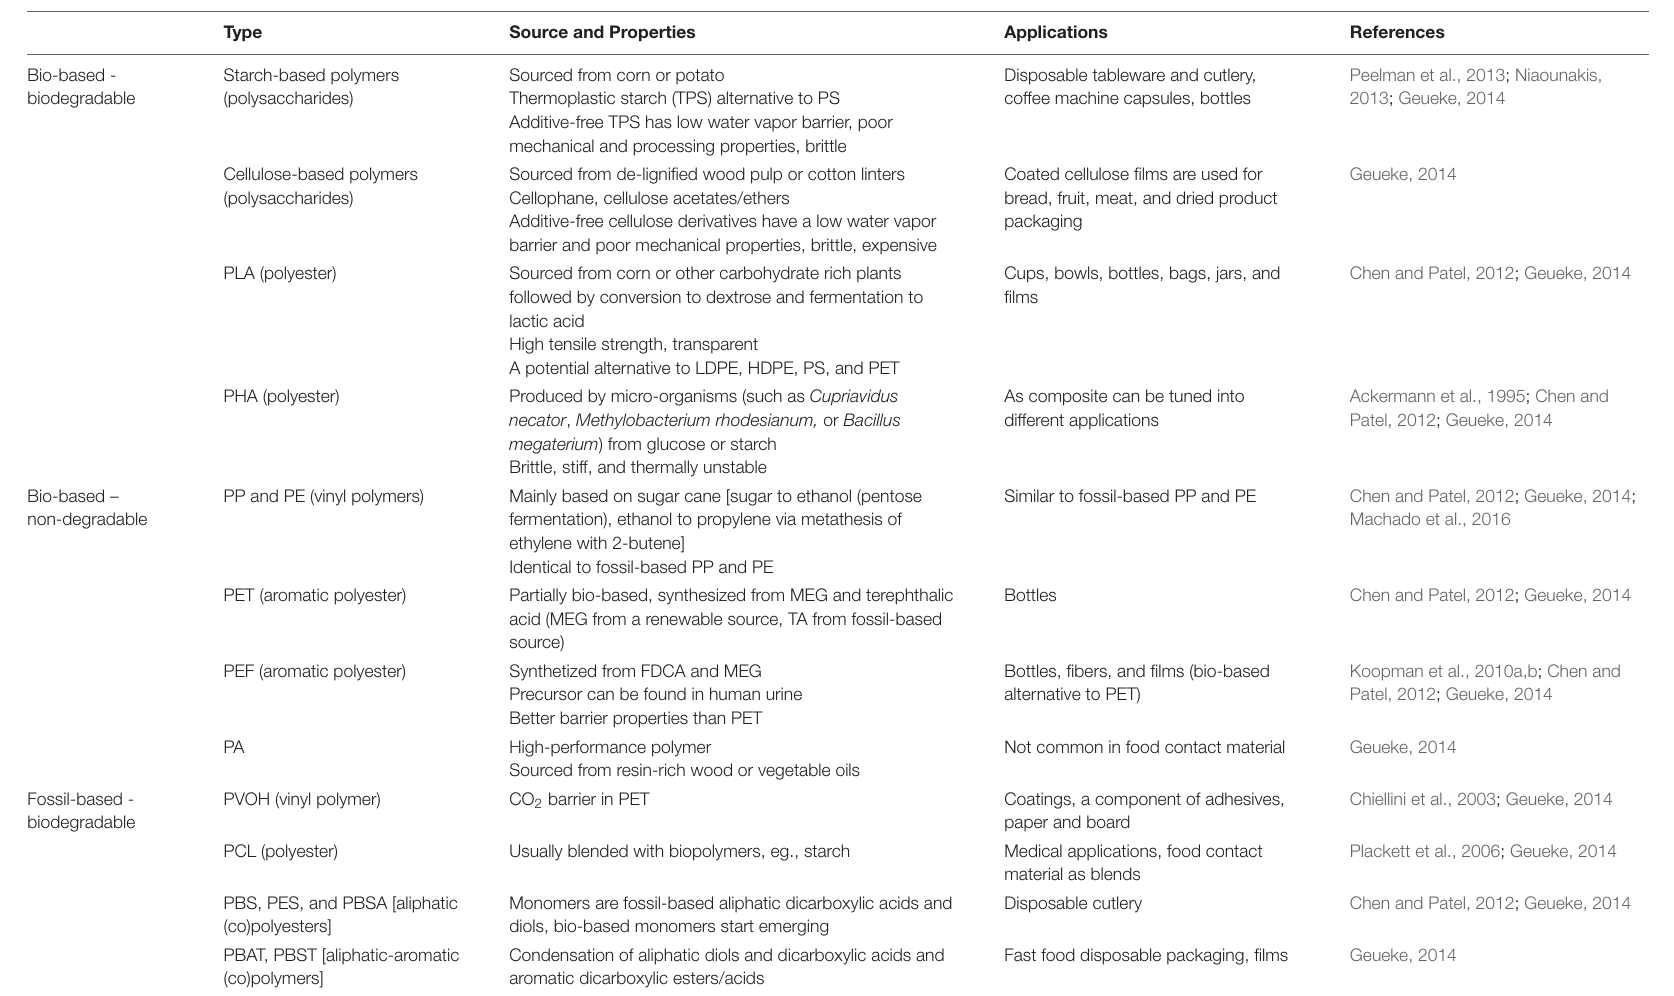
TABLE 1 | Bio-based plastics in food